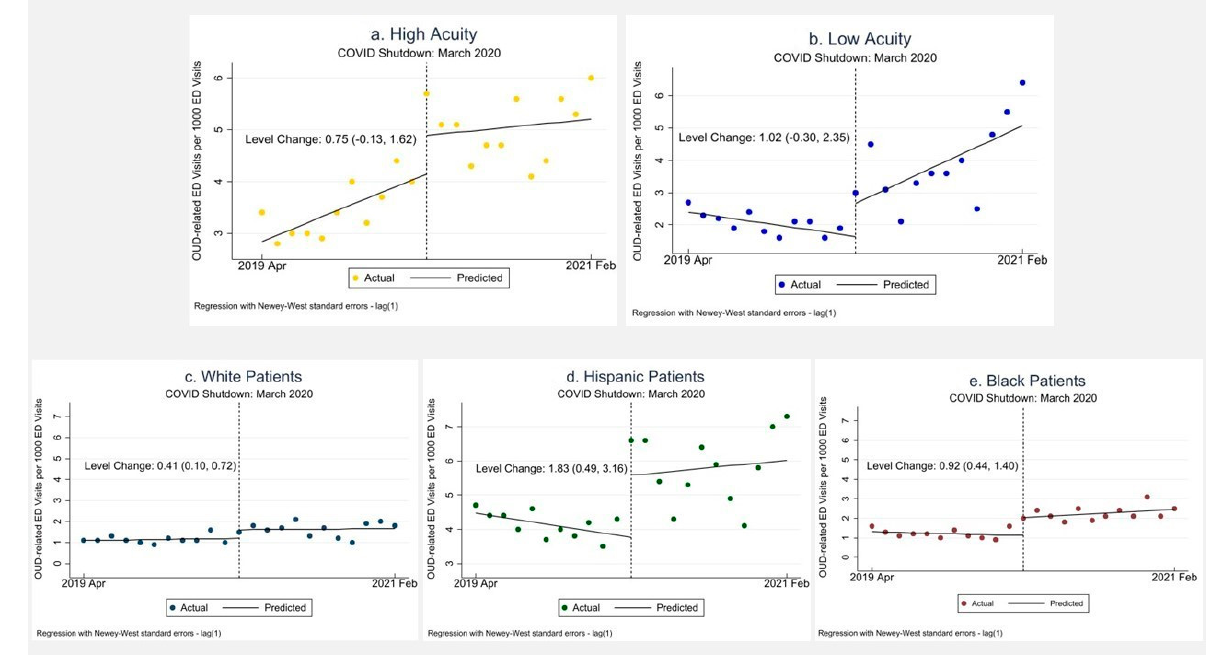
Figure 2. Interrupted Time Series for Opioid-Use-Disorder-related Emergency Department visits ( a ) High-Acuity Visits; ( b ) Low-Acuity Visits; ( c ) White Patients; ( d ) Hispanic Patients; ( e ) Black Pa-